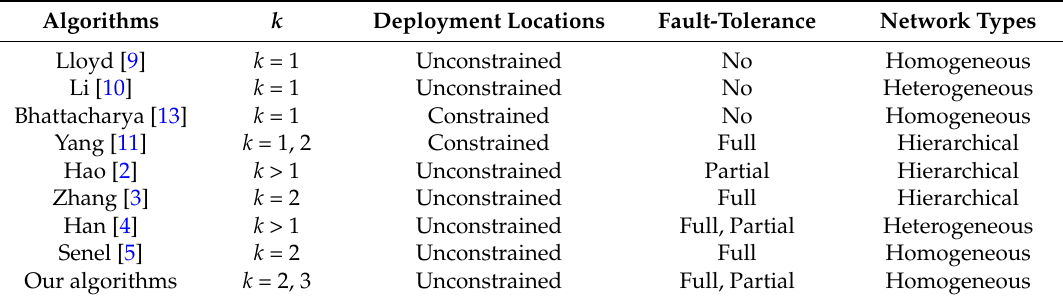
Table 1. Relay placement